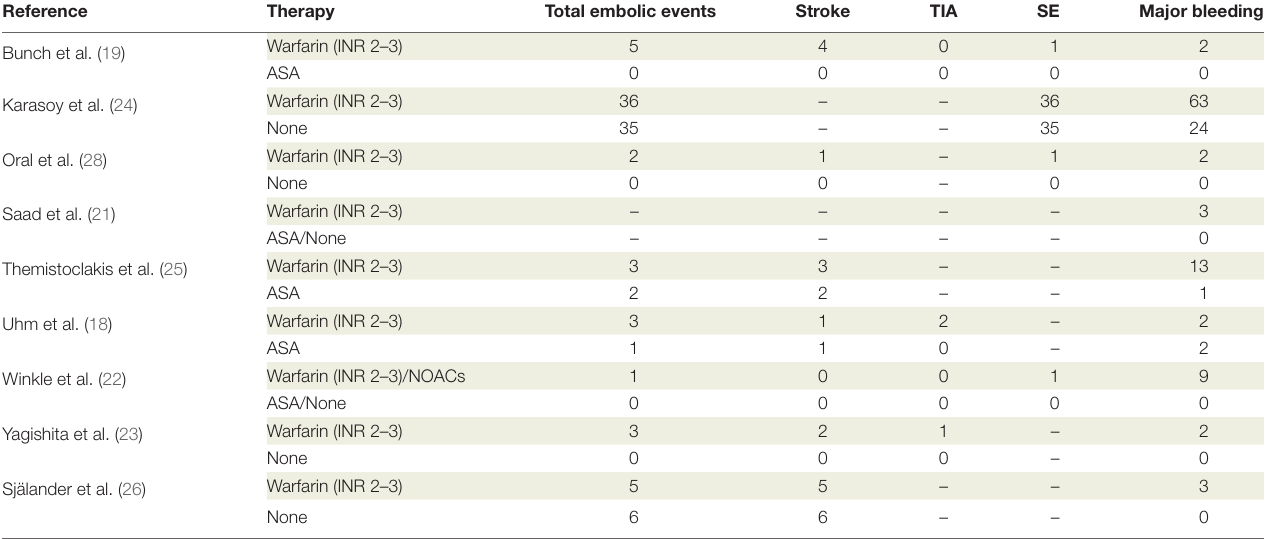
taBLe 2 | Events’ list for each study included in the meta-analysis.